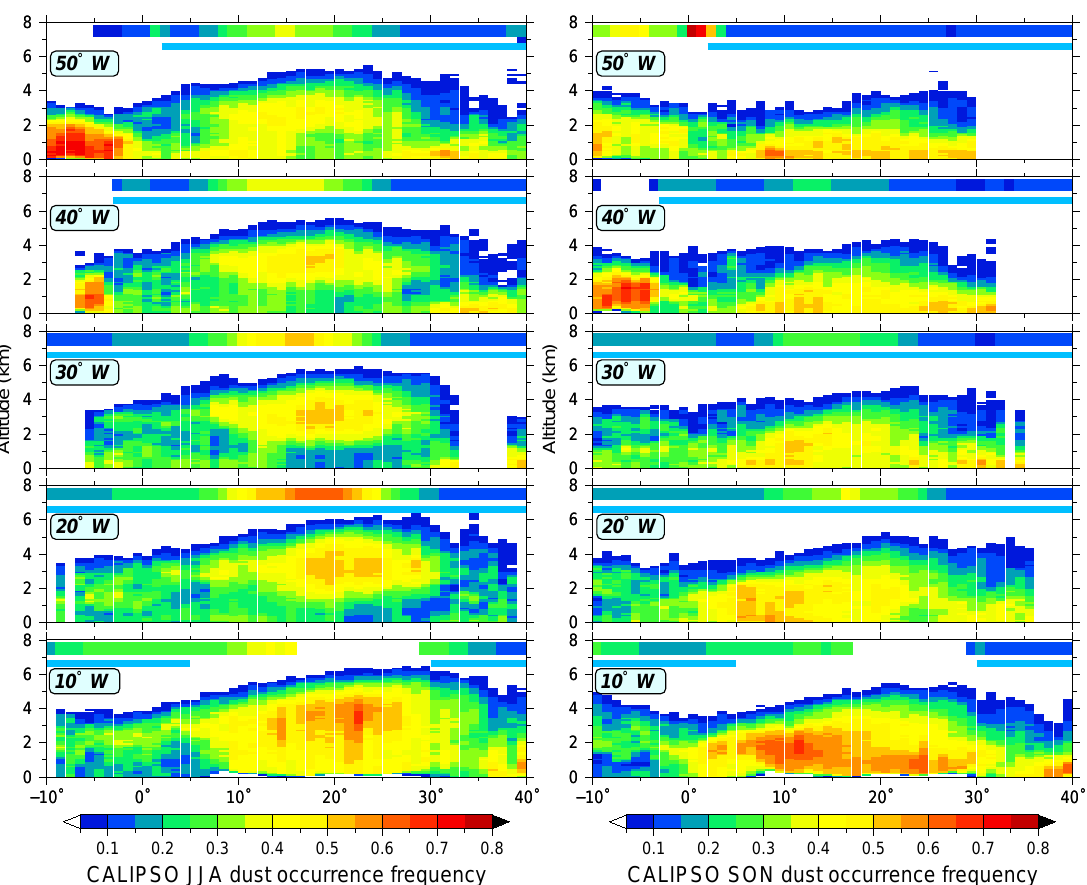
Fig. 4. Same as Fig. 3 but for summer (JJA – left) and fall (SON – right) seasons.